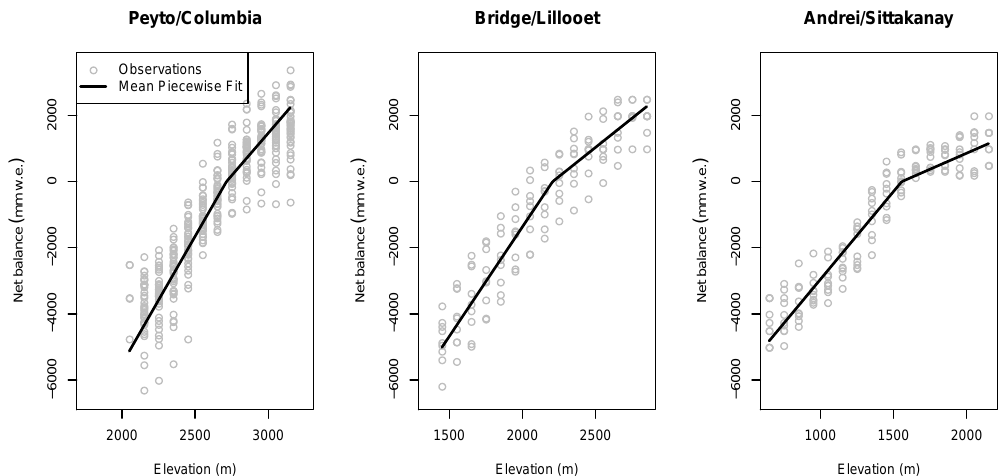
Fig. 5. Observed net mass balance by elevation band for Peyto (Columbia), Bridge (Lillooet), and Andrei (Sittakanay) glaciers and icefields. Solid black lines denote mean fitted mass balance gradients. Table 3. Median elevations ( Z med , inm a.s.l.) for mass balance sites and glacierized regions, and mean ( x ) and standard deviation ( σ ) of